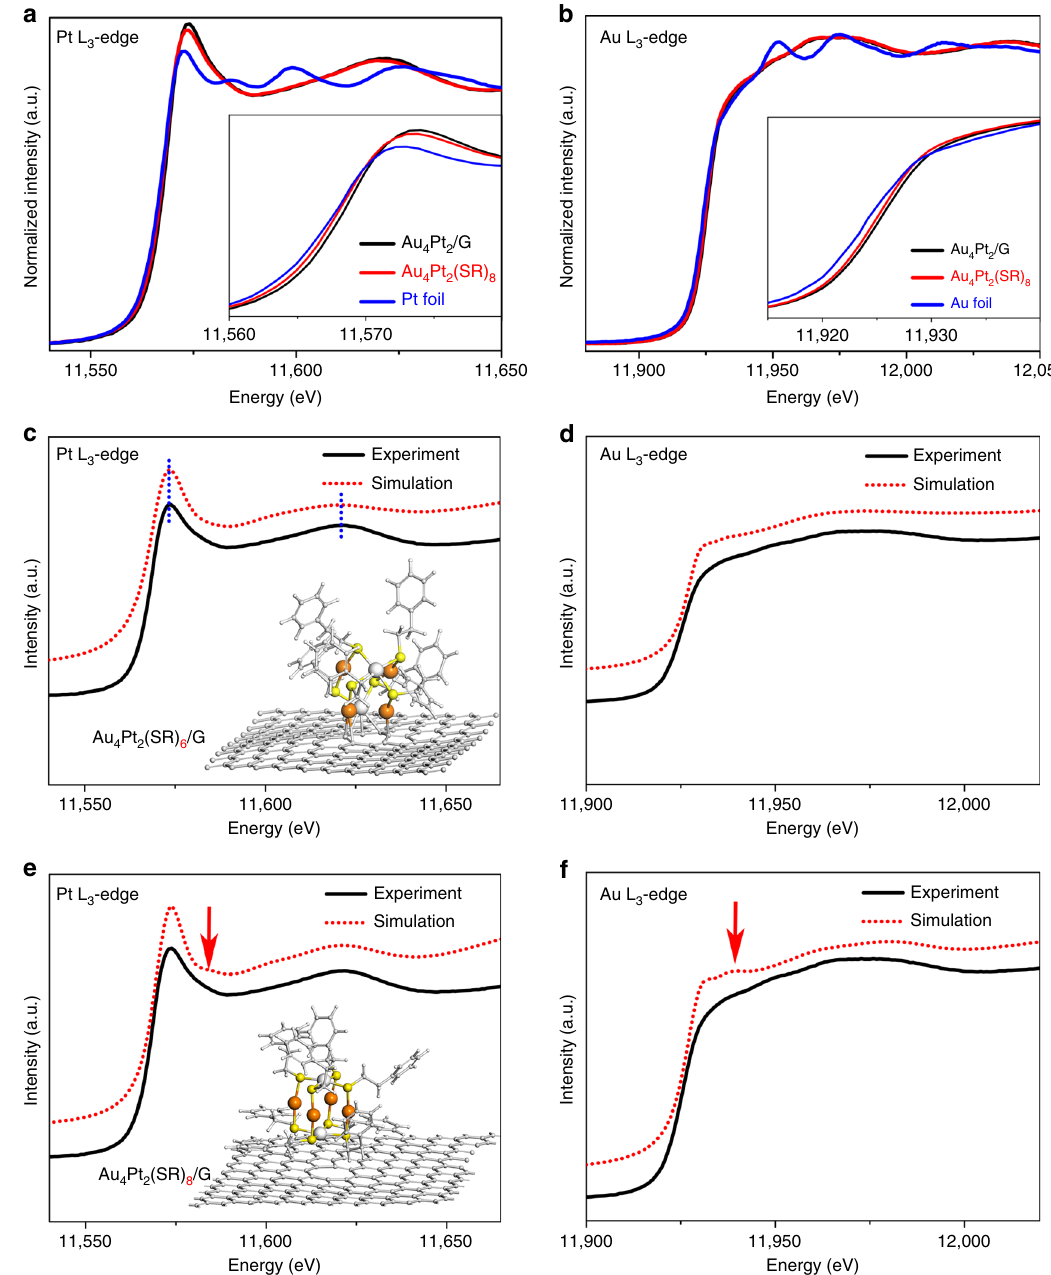
Fig. 4 Pt and Au L 3 -edge XANES spectra. a , b Normalized XANES spectra of the Pt L 3 - and Au L 3 -edges for Au 4 Pt 2 /G, Au 4 Pt 2 (SR) 8 , and Pt foil (insets show expanded data). c , d Comparison of experimental XANES spectra of the Pt L 3 - and Au L 3 -edges for Au 4 Pt 2 /G (black line) with that of the simulated spectrum (red dot-line) using the DFT-modeled structure, Au 4 Pt 2 (SR) 6 /G (inset). e , f Comparison of the experimental XANES spectrum of the Pt L 3 - and Au L 3 -edge of the Au 4 Pt 2 /G (black line) with that of the simulated spectrum (red dot-line) based on the DFT-modeled structure, Au 4 Pt 2 (SR) 8 /G